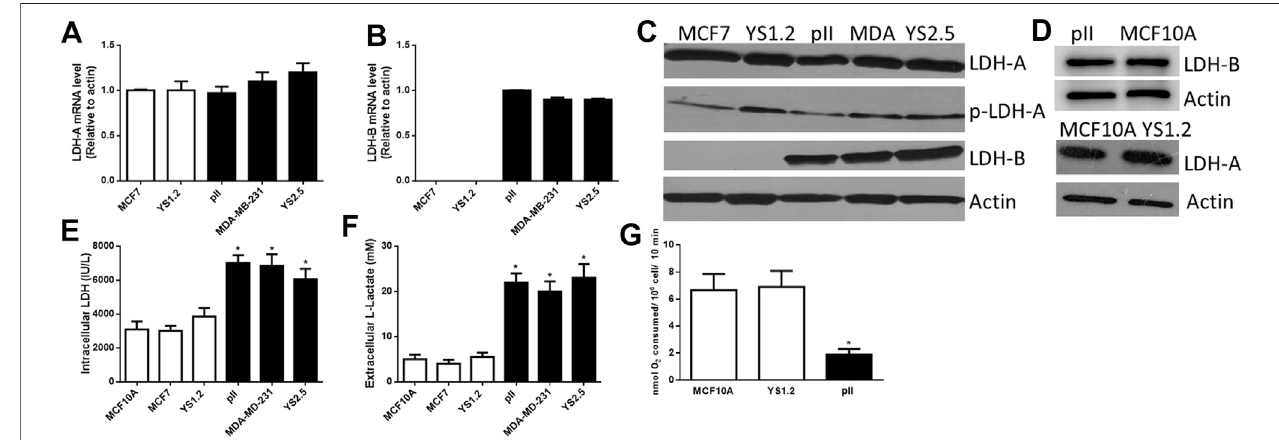
FIGURE 1 | The expression pro fi le of lactate dehydrogenase isoenzymes and lactate in the tested cell lines. LDH-A [ (A) , normalized to MCF7], and LDH-B [ (B) , normalized to pII] mRNA expression pro fi le in ER +ve (MCF7 and YS1.2) and ER − ve (pII, MDA-231, and YS2.5) cells. * p < 0.05 Vs. MCF7 and YS1.2 ( n (cid:2) 3 per group). (C,D) showwesternblottinganalysisofLDH-A(totalandphospho),LDH-B,andactin(loadingcontrol)forthetestedcelllines.Theblotrepresentsoneoutofthreesimilar experiments. (E,F) show intracellular LDH activity and extracellular lactate level in the tested cell lines. * p < 0.05 Vs. YS1.2, MCF7, and MCF10A ( n (cid:2) 6 per group). (G) shows oxygen consumption rate in the tested cell lines. * p < 0.05 Vs. YS1.2, MCF10A ( n (cid:2) 6 per